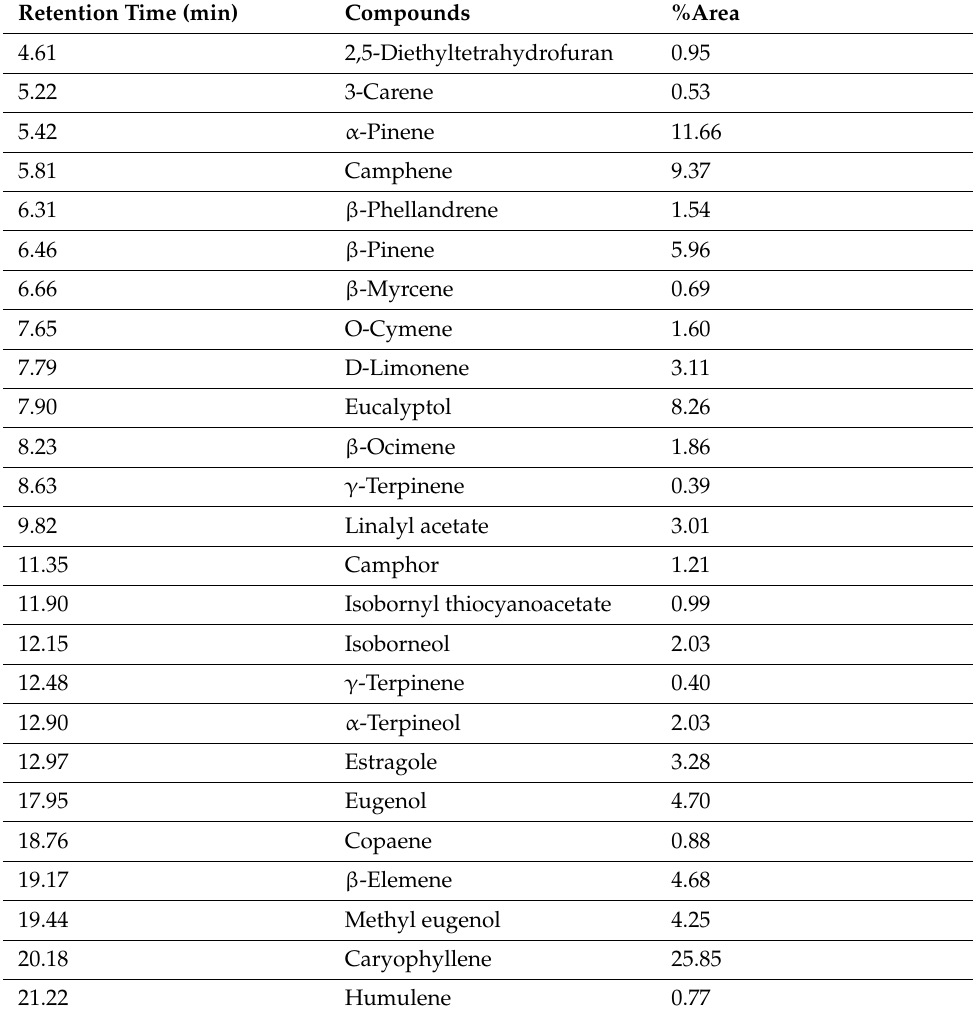
Table 2. Chemical composition of the essential oil extracted from O. tenuiflorum